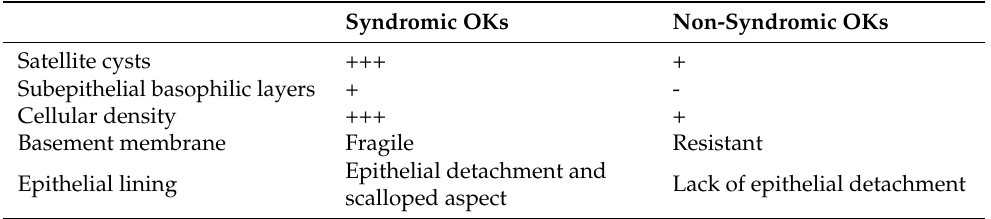
Table 2. CLSM typical features of 120 syndromic and 93 sporadic OKs. Syndromic OKs Non-Syndromic OKs Satellite cysts +++ + Subepithelial basophilic layers + - Cellular density +++ + Basement membrane Fragile Resistant Epithelial detachment and Lack of epithelial Epithelial lining scalloped aspect